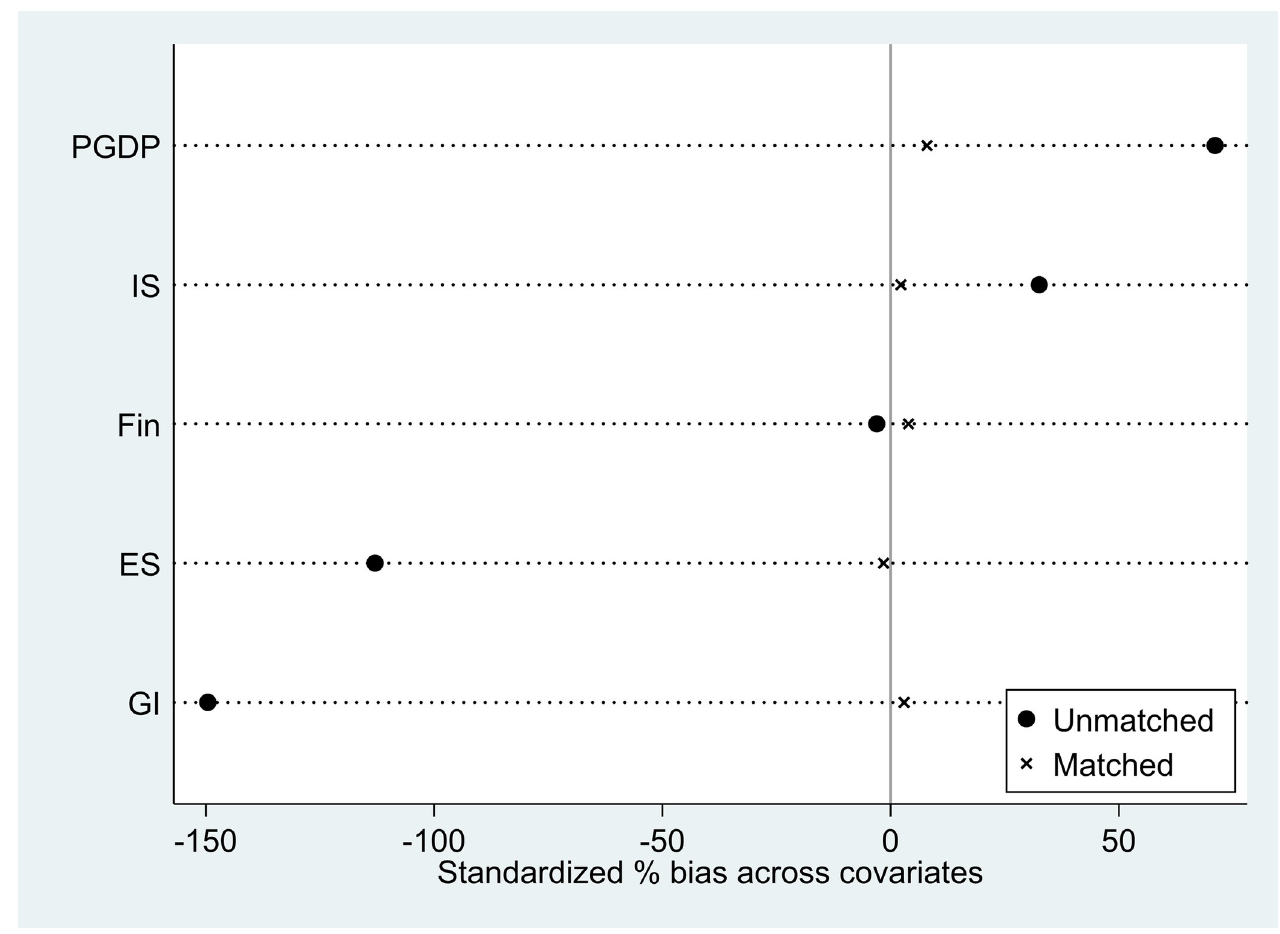
Fig 2. Differences in covariates of variables before and after matching.